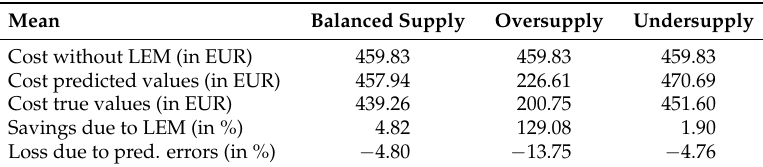
Table 5. Average savings for consumers due to the LEM and average loss for consumers due to prediction errors in the